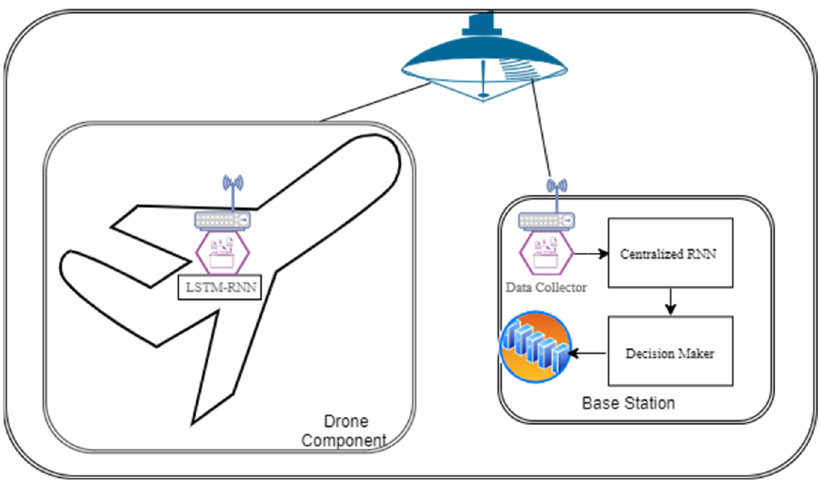
Figure 1. Drone intrusion detection framework.